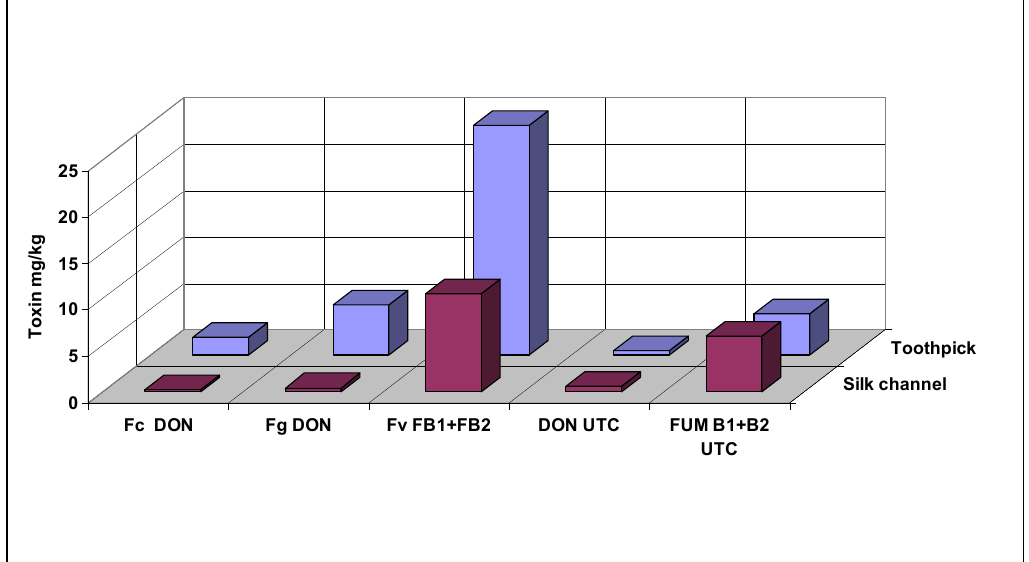
Figure 11. Comparison of ear rot results from the silk channel and toothpick methods in maize inoculation methods, 2010–2012.